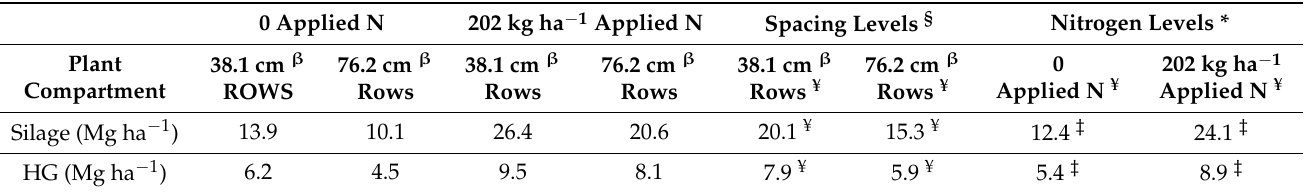
Table 3. Differences in total biomass silage and harvested grain (HG) mean dry weight yields (Mg ha − 1 ) of corn grown in the small plots (study 2) during 2019 under different row spacing systems and nitrogen rates ¶ .